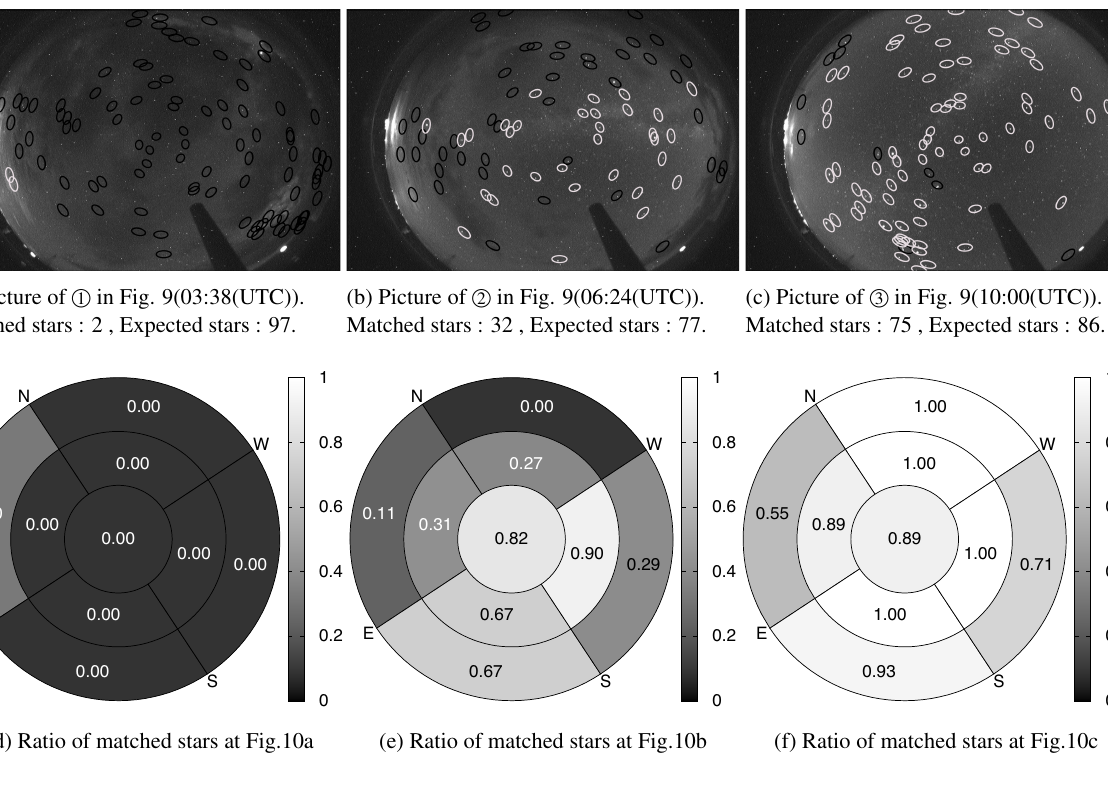
(e) Ratio of matched stars at Fig.10b (f) Ratio of matched stars at Fig.10c Figure 10: Pictures and its ratio of matched stars at the time indicated by gray dashed box ( 1 ⃝ (cid:24) 3 ⃝ ) in Fig. 9.